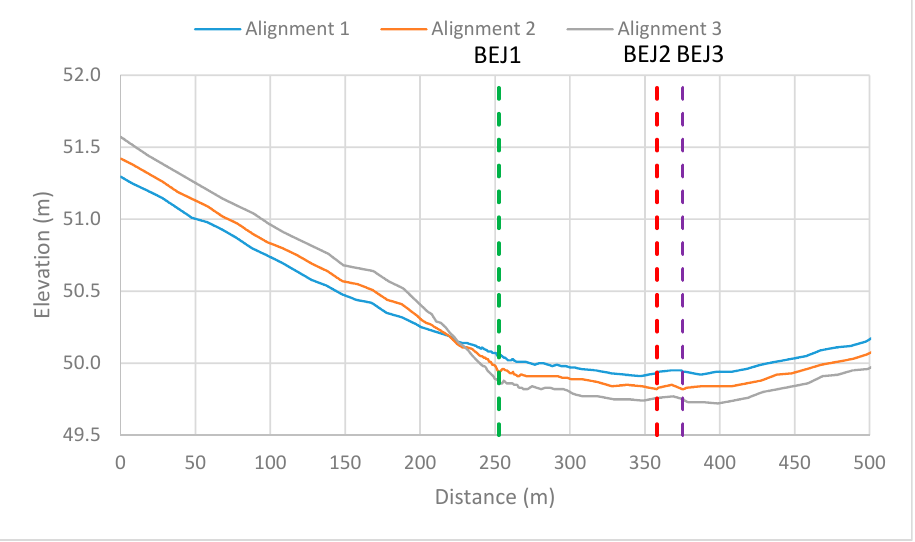
Figure 13. Road longitudinal profiles and the BEJs’ location.